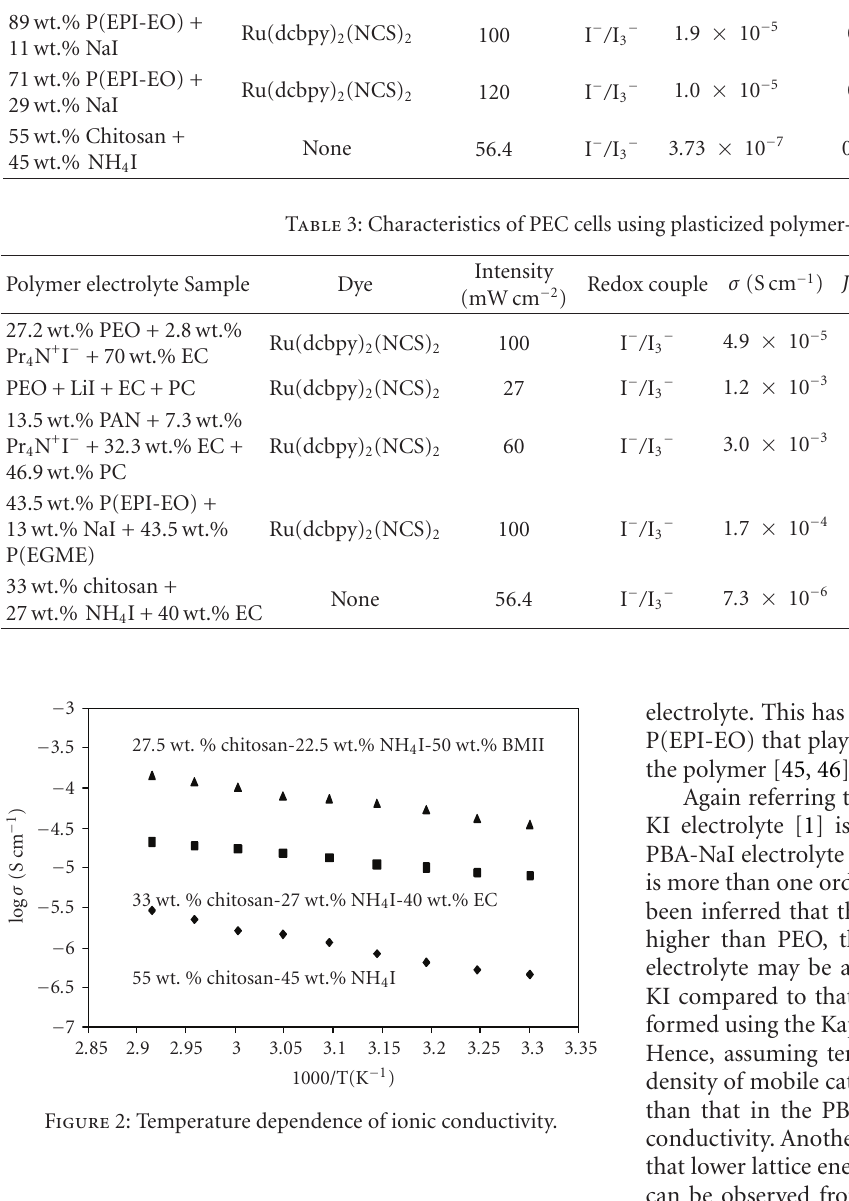
of PEO [38] because for a higher salt content in the PEO- NaI electrolyte, the conductivity is almost similar to that of PBA-NaI electrolyte at room temperature (assumed 298